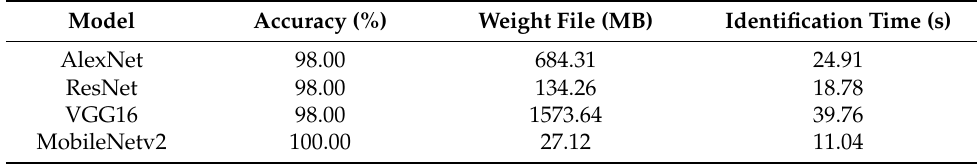
Table 8. Identification results of vehicle weight for different models.